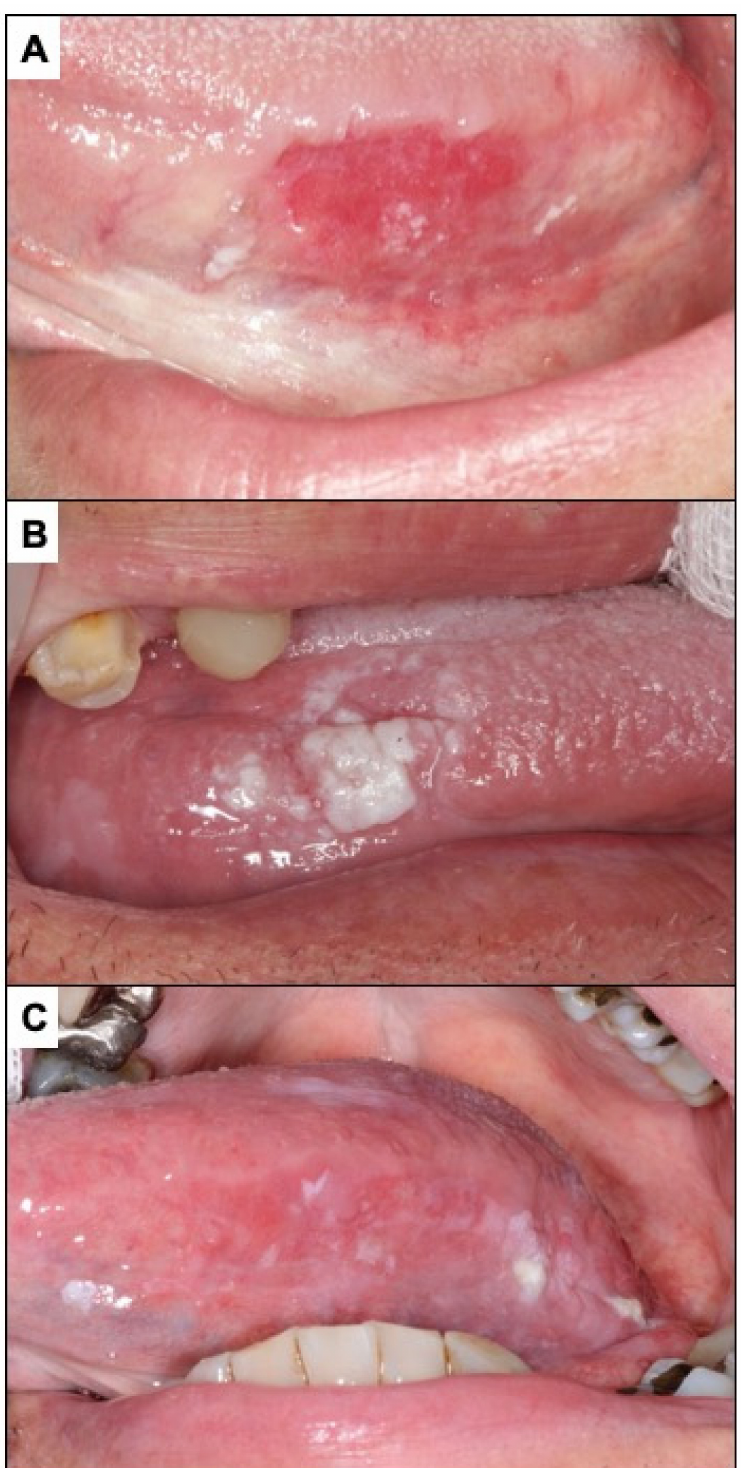
Figure 5. ( A ). Erythroplasia of the lateral border of the tongue. ( B ). Oral carcinoma with leukoplakia- like appearance on the lateral border of the tongue. ( C ).